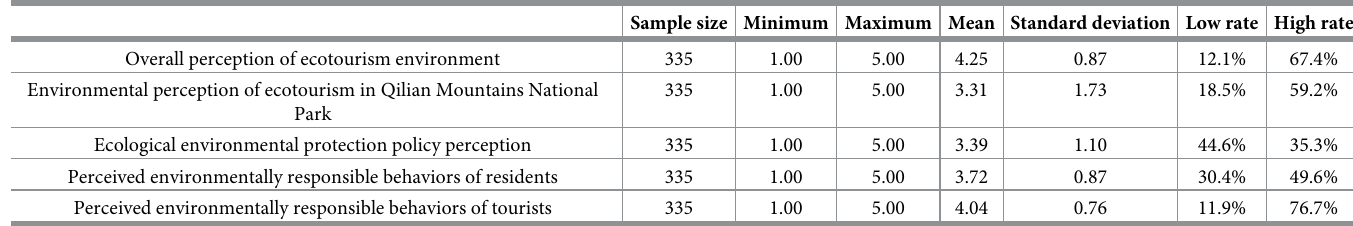
Table 7. Statistical analysis chart of resident